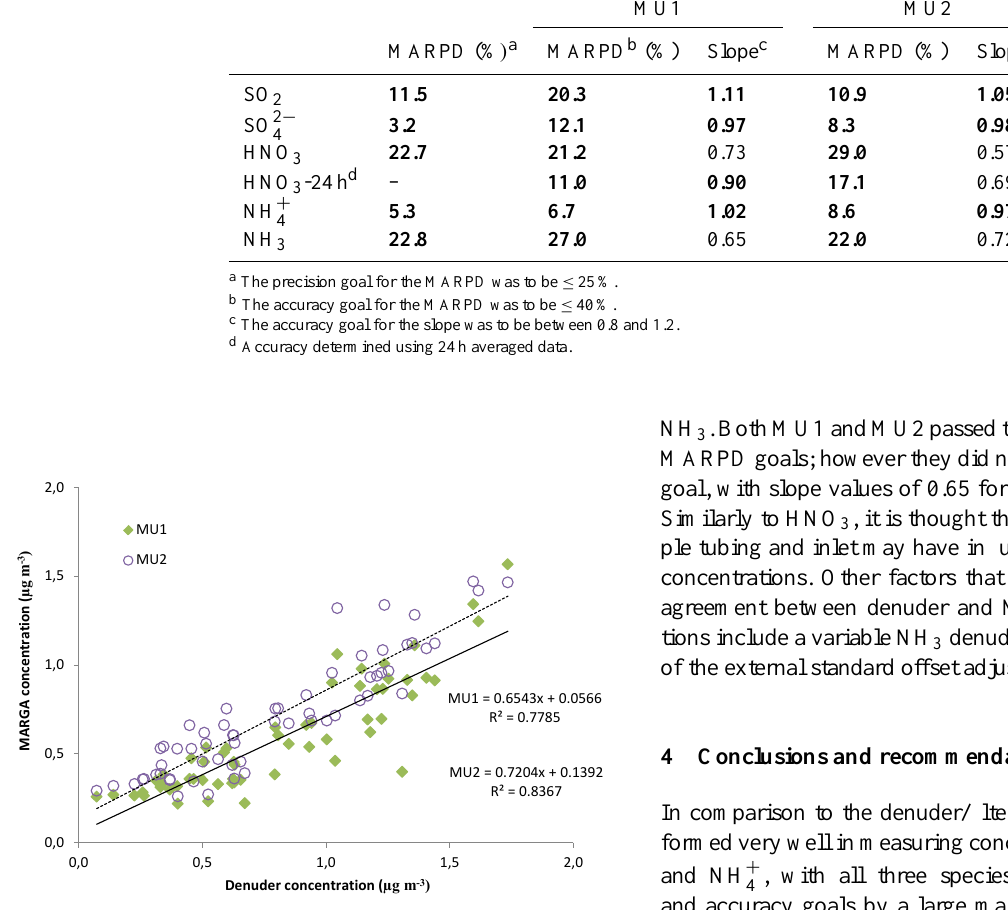
Figure 22. Regression analysis of MARGA NH 3 concentrations against denuder NH 3 Fig. 22. Regression analysis of MARGA NH 3 concentrations against filter pack NH 3 concentrations. 2